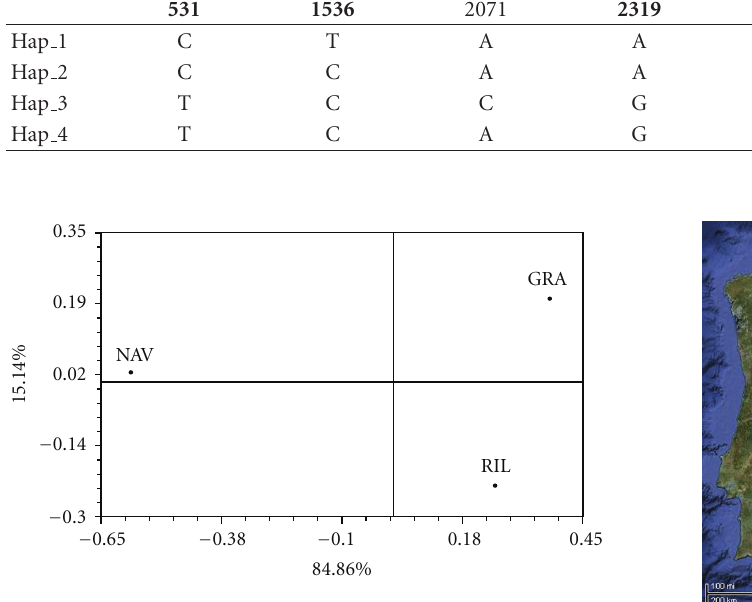
Figure 1: Results of the PCA analysis based on mtDNA sequences from three samples of A. italicus . Eigenvalues for each principal component are listed besides each axis.